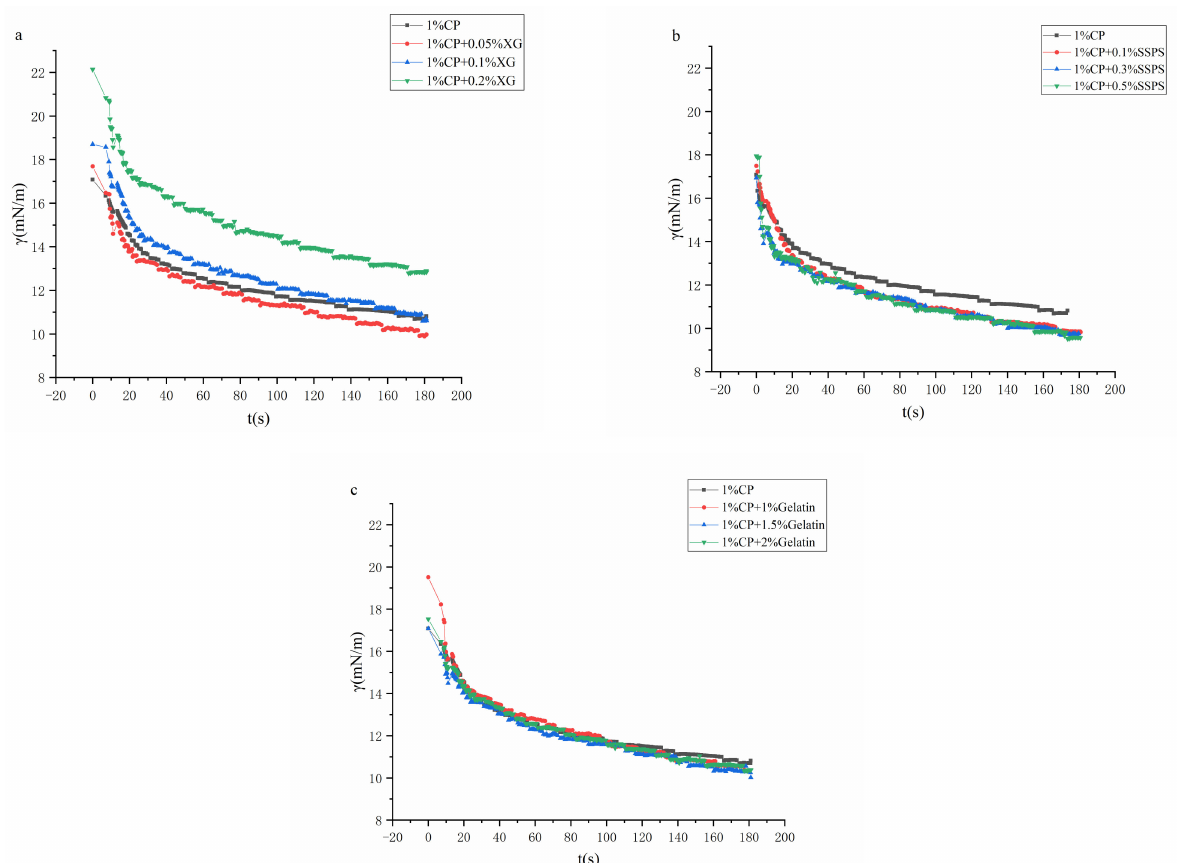
Figure 6. Dynamic interfacial tension ( γ ) for sample solutions at the oil–water interface. ( a ) CP-XG; ( b ) CP-SPSS; and ( c ) CP-Gelatin. (CP-Coconut protein, XG-Xanthan gum, SSPS-Soluble soybean